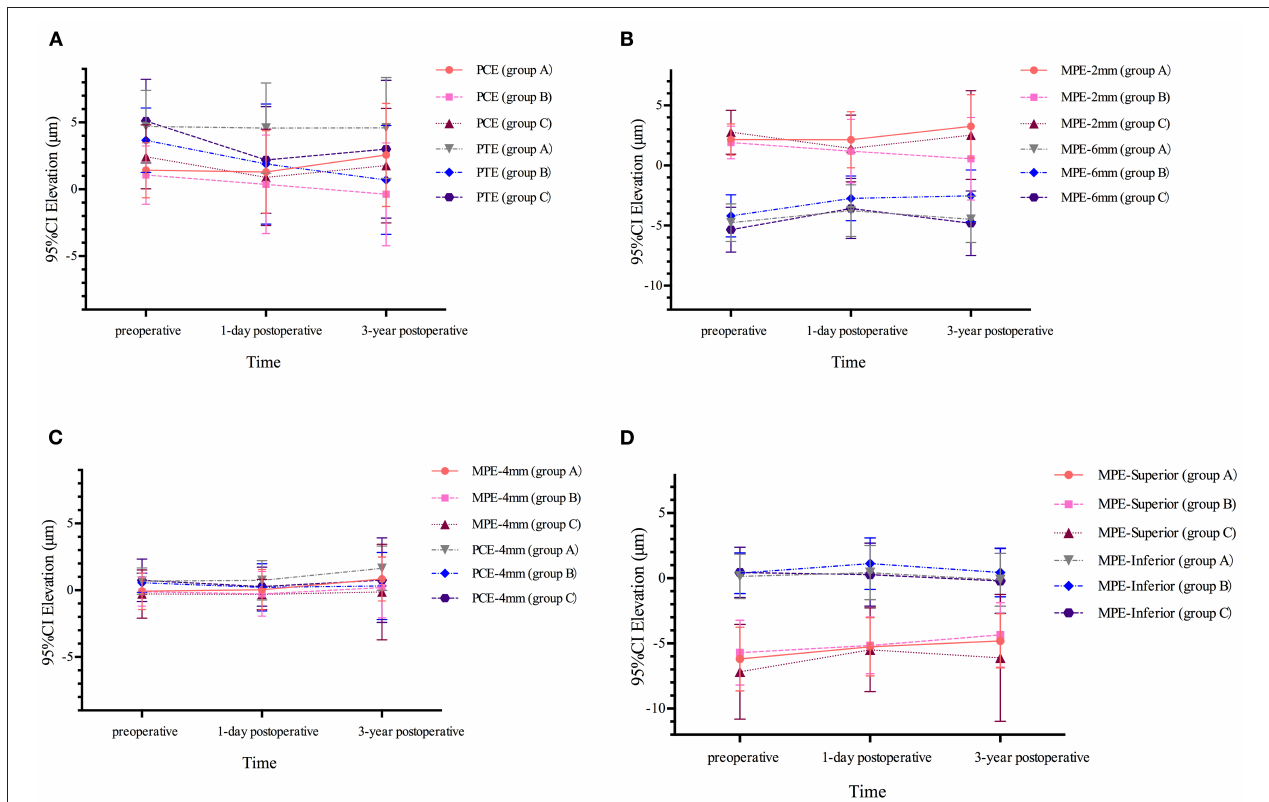
FIGURE 2 | Posterior corneal elevation before and after SMILE in three groups. (A) Posterior elevation in central (PCE) and preoperative thinnest point (PTE) in three groups. (B) Posterior elevation in 2mm diameter (MPE-2mm) and 6mm diameter (MPE-6mm) in three groups. (C) Posterior elevation in 4mm diameter (MPE-4mm) and central 4mm area (PCE-4mm) in three groups. (D) Posterior elevation in superior hemisphere (MPE-Superior) and inferior hemisphere (MPE-Inferior) in three groups.